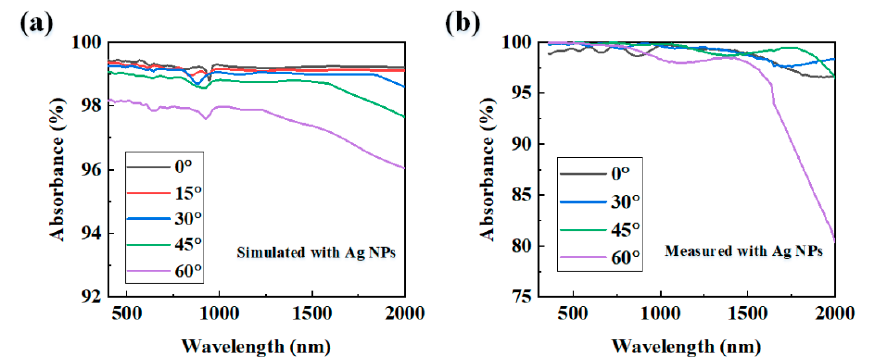
Figure 6. Absorbance spectrum of the nanostructured Si metasurface at different angles of incidence from 0° to 60° with an interval of 15°; ( a ) simulated and ( b ) measured with Ag NPs.